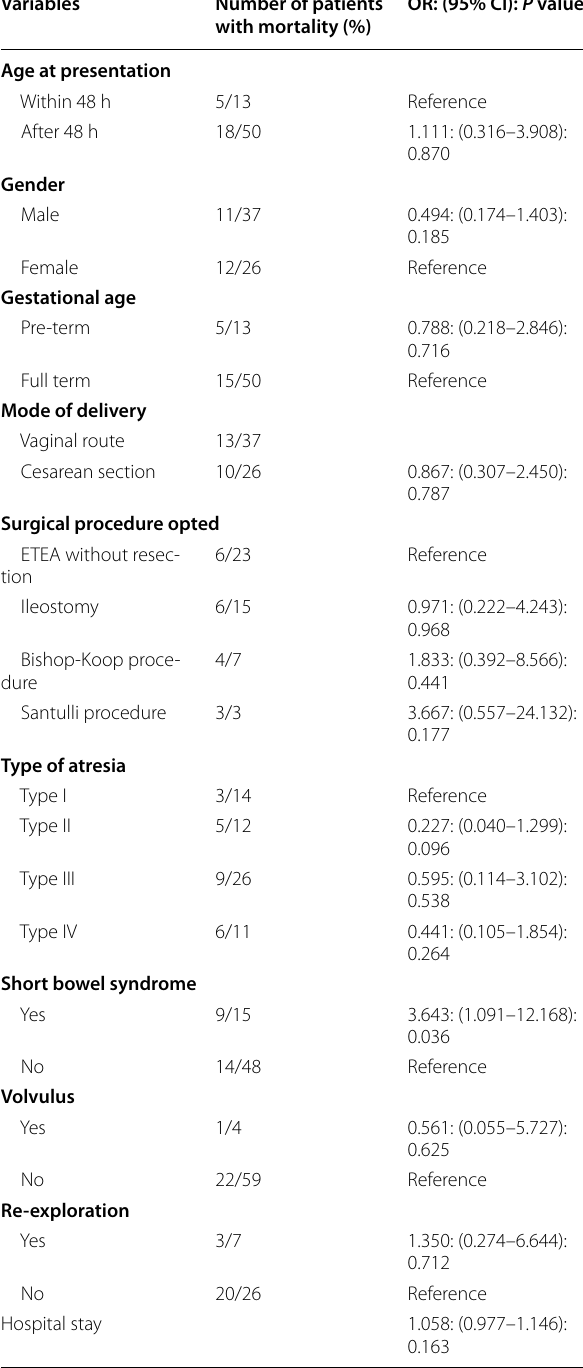
Table 2 Logistic regression for factors leading to mortality Variables Number of patients with mortality